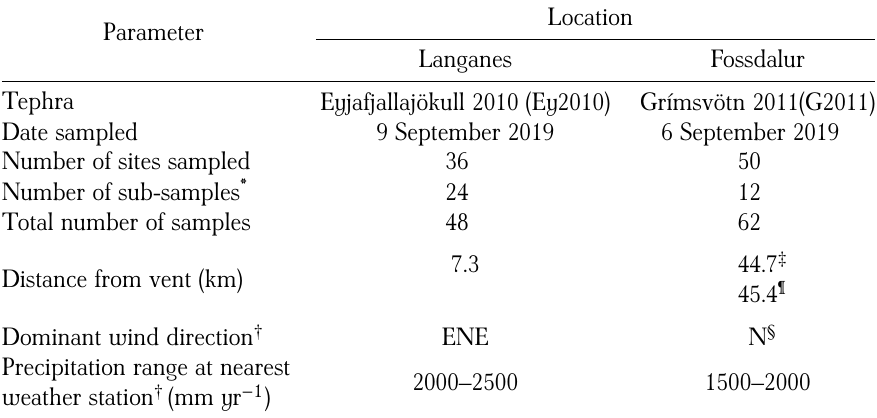
Table 1: Number of samples collected at the two locations with additional location